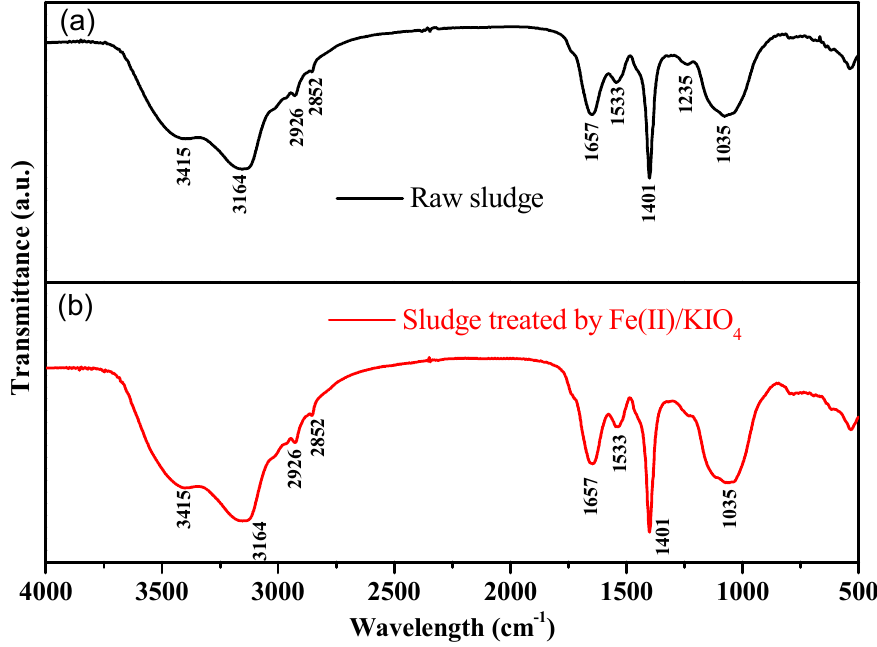
Figure 5. FT-IR spectra of ( a ) raw sludge and ( b ) sludge treated by Fe( Ⅱ )/KIO 4 process. Conditions: Initial pH = 6.8, KIO 4 dose = 1.4 mmol/g VSS, Fe( Ⅱ )/KIO 4 molar ratio = 1.2.